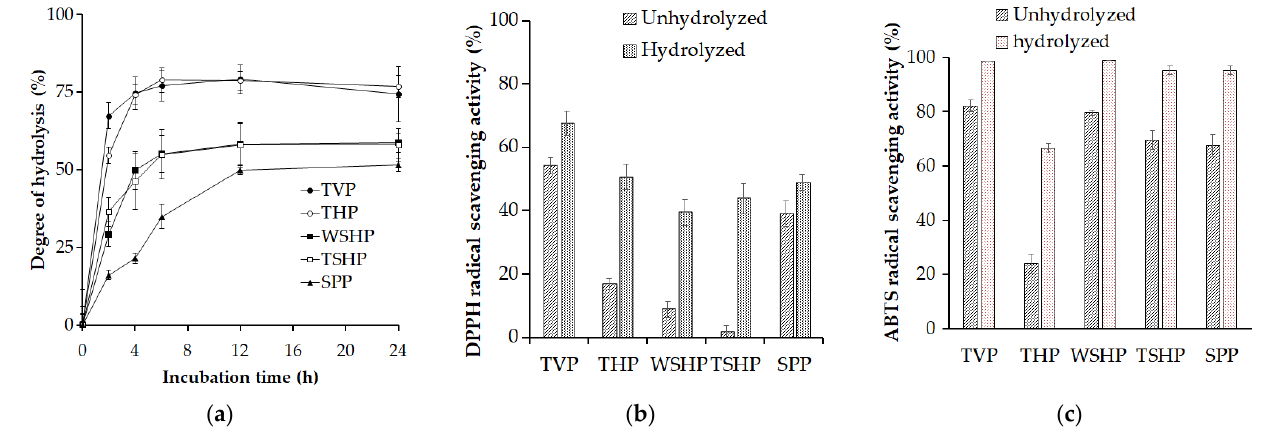
Figure 4. Degree of hydrolysis of fishery wastes treated by P. elgii TKU051 protease ( a ) and 2,2-diphenyl-1-picryl-hydrazyl-hydrate (DPPH) radical scavenging activity ( b ) and 2,2 ′ -azino-bis(3-ethylbenzothiazoline-6-sulfonic acid (ABTS) radical scavenging activity ( c ) of fish- ery wastes hydrolysates. The error bars refer to the standard deviation of three replications.